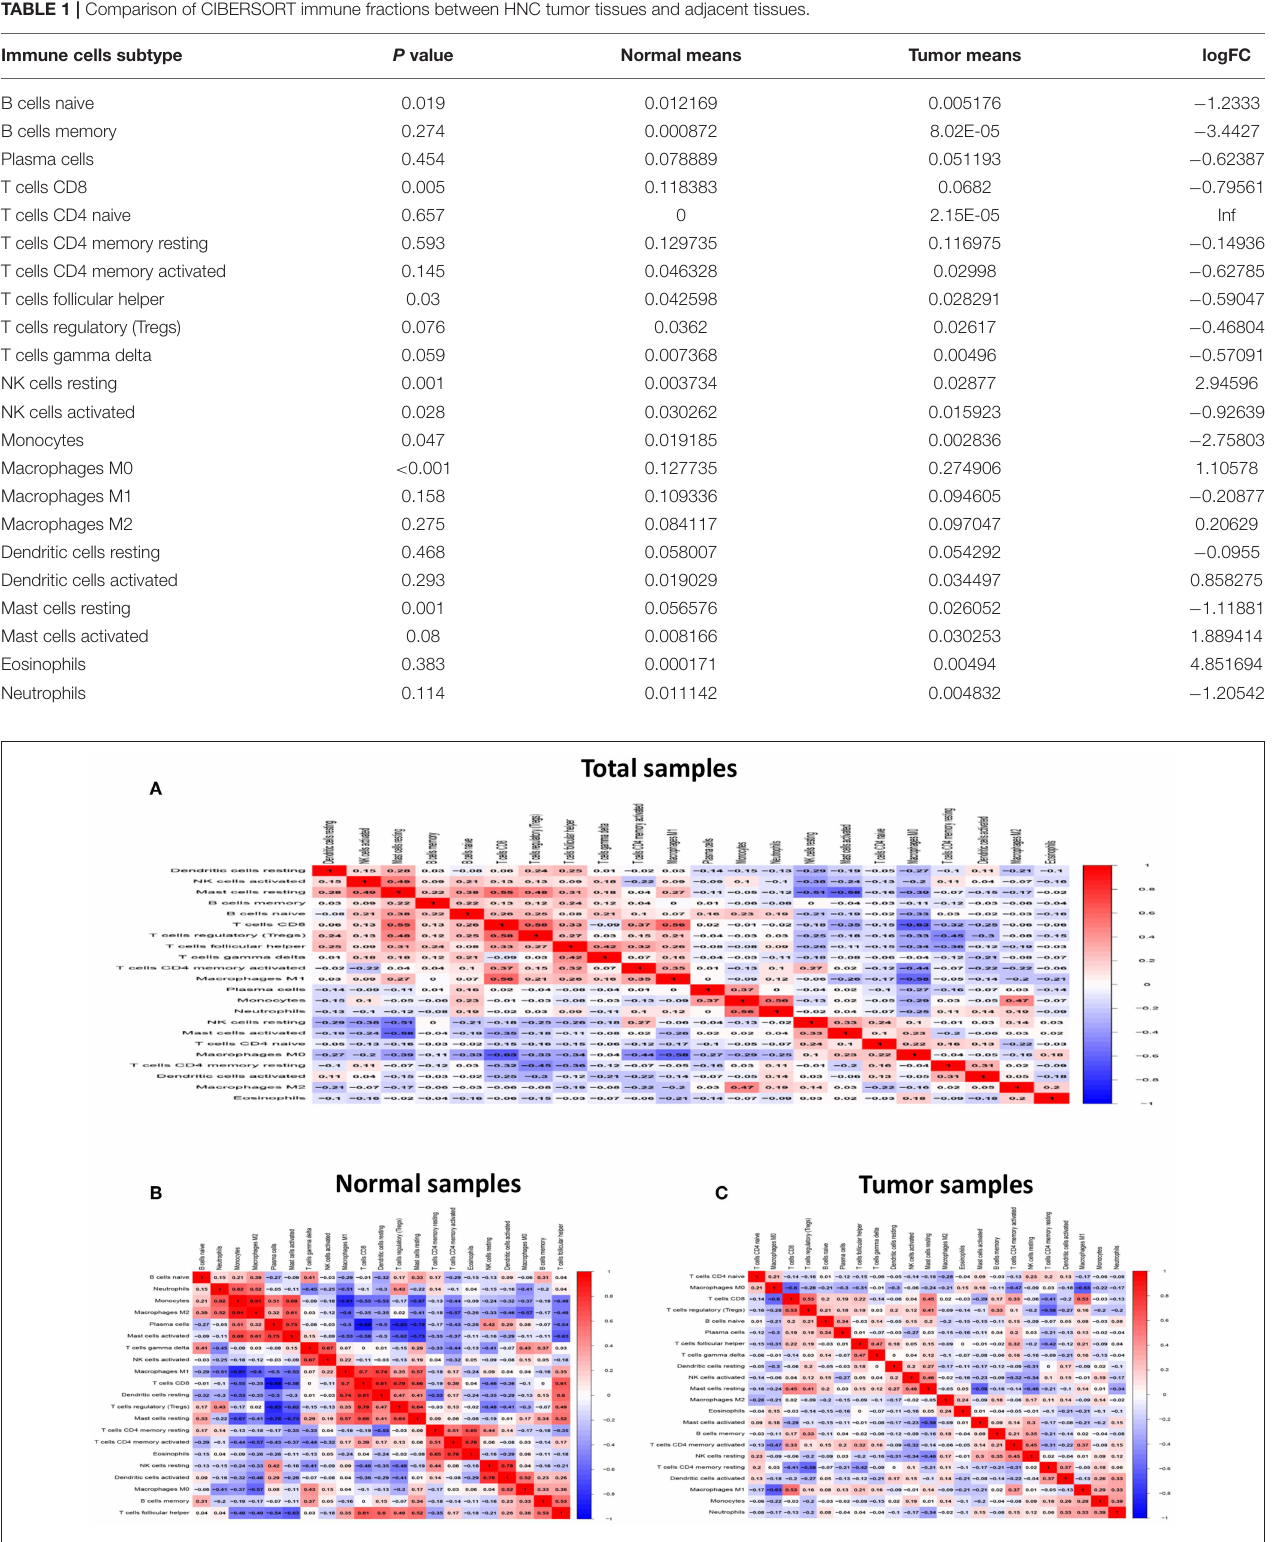
FIGURE 4 | Correlation matrix of all 22 immune proportions and immune cytolytic activity in the TCGA HNC cohort, including total samples (A) , normal samples (B) and tumor samples (C) .